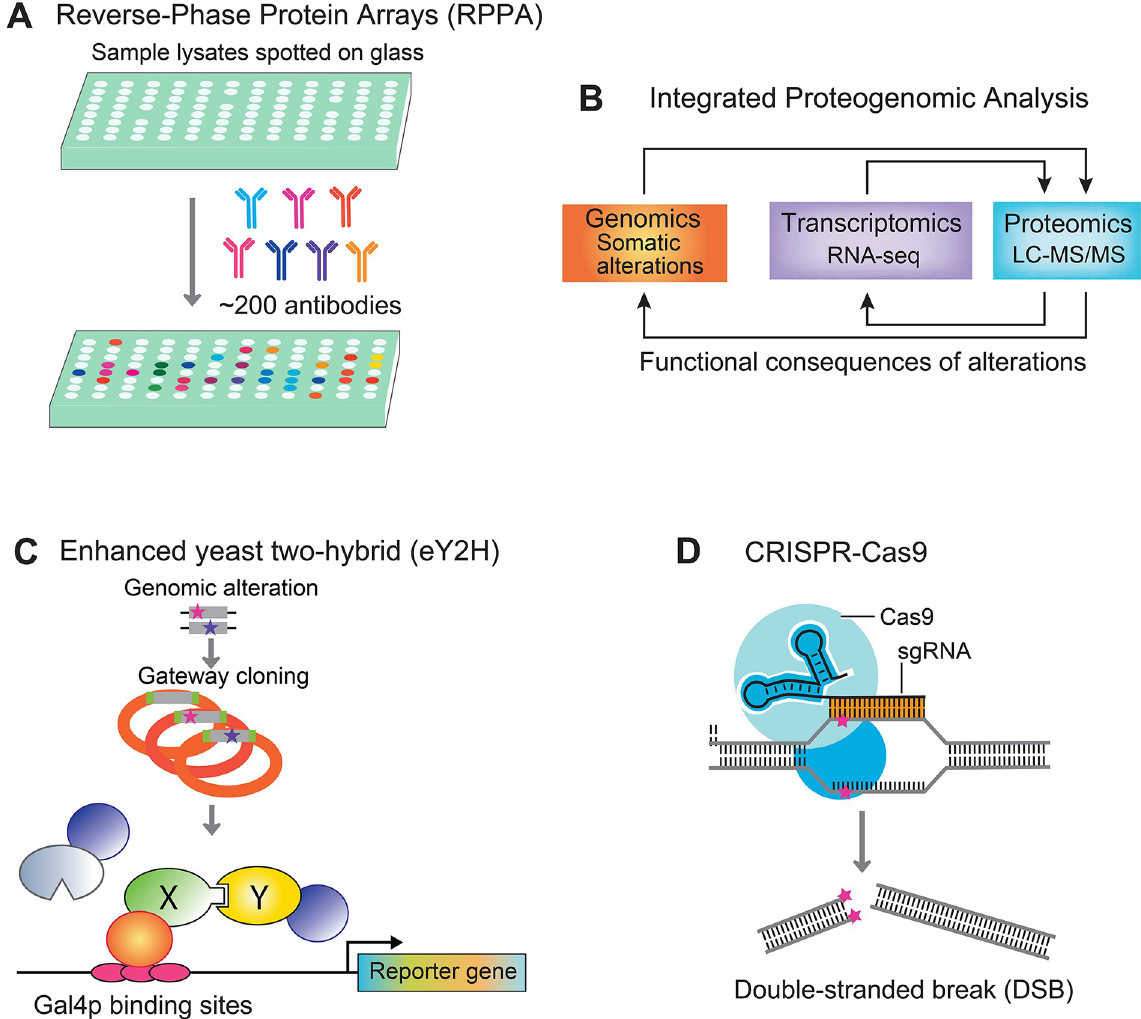
Fig 4. Examples of experimental strategies to explore the functional consequences of mutations altering tumorigenesis, disease progression, and drug responses. These include (A) RPPA technology, (B) integrated proteogenomic analysis, (C) high-throughput gateway- compatible enhanced yeast two-hybrid, and (D) CRISPR-Cas9 genome editing. LC-MS/MS, liquid chromatography—tandem mass spectrometry; RPPA, reverse-phase protein